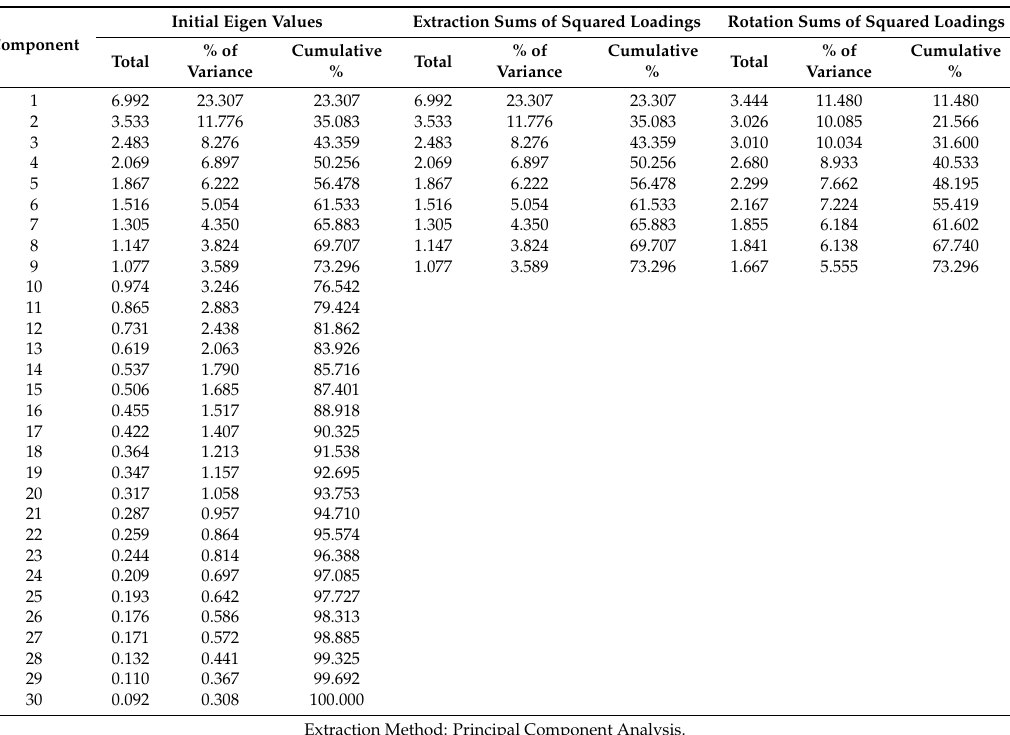
Table 8. Total Variance